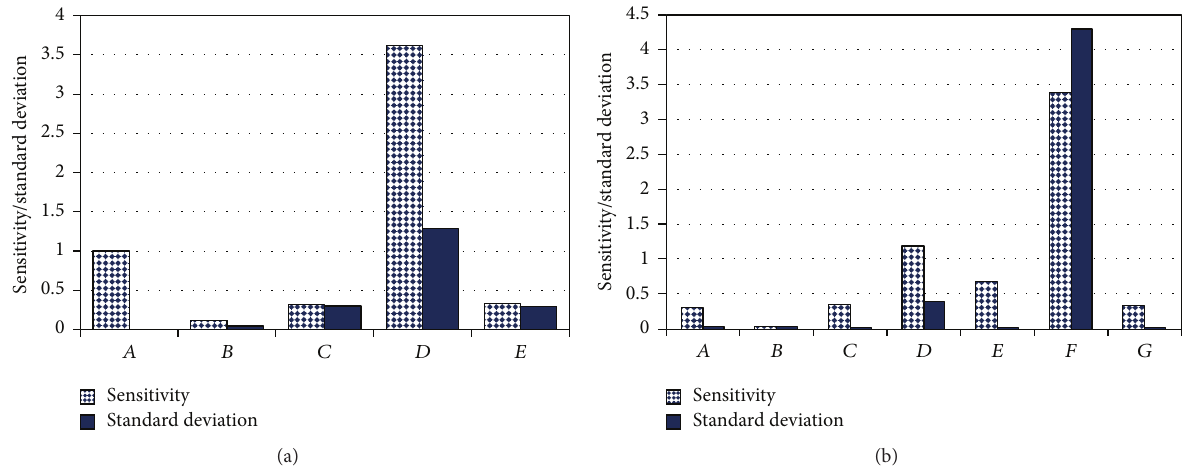
Figure 9: Sensitivity of the flow stress with respect to coefficients in (3) (a) and (4) (b) and standard deviations for these sensitivities.